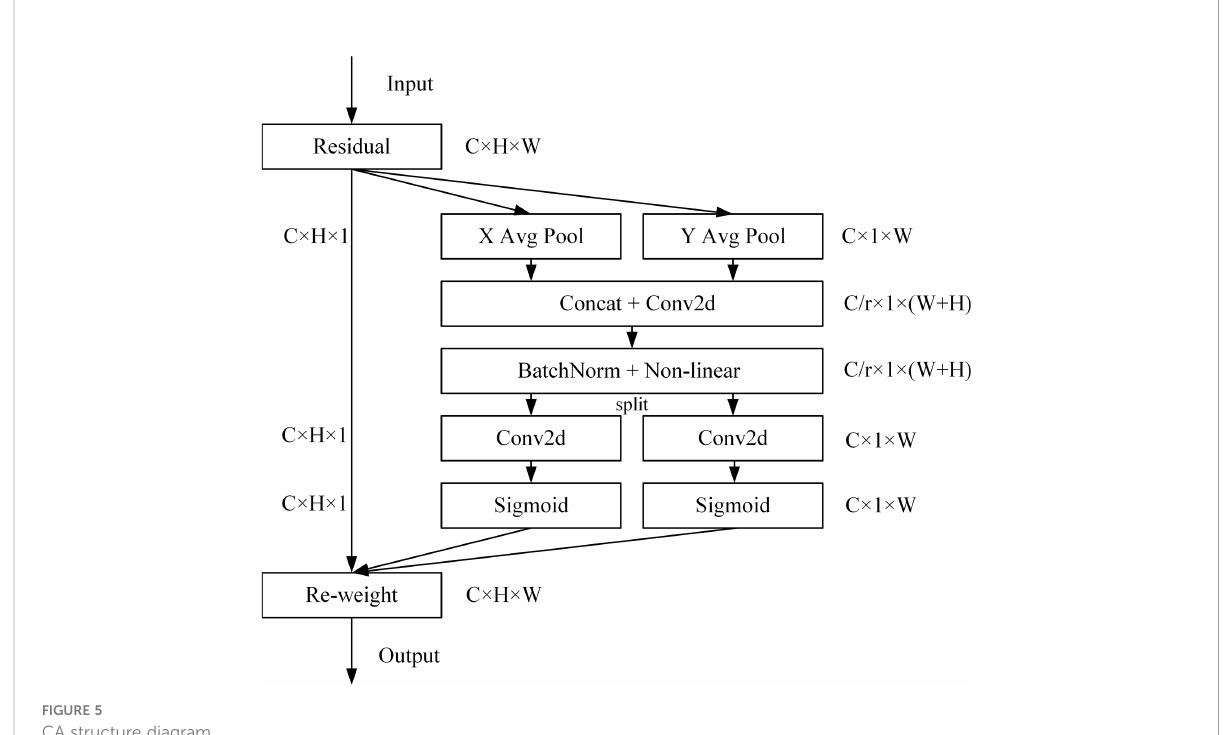
FIGURE 5 CA structure